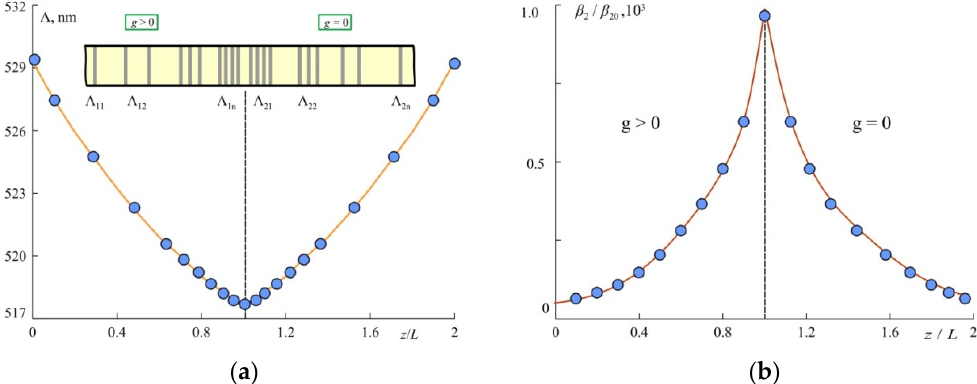
Figure 3. Arrangement of the inscribed FBGs ( a ) and the second-order dispersion profile ( b ) in the cascaded fiber config- uration comprising one active and one passive fiber. The length of the active and passive fiber segment is l = 22.5cm, g 1 = 0.2cm − 1 , and g 2 =